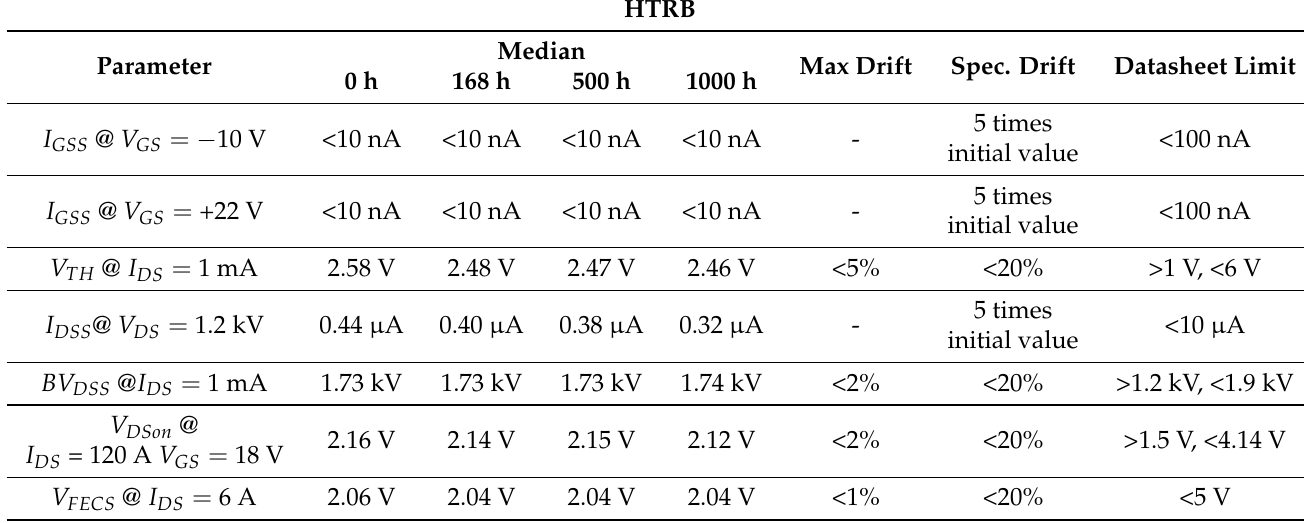
Table 5. Drifts of some GEN3 SiC MOSFET electrical parameters for the HTRB